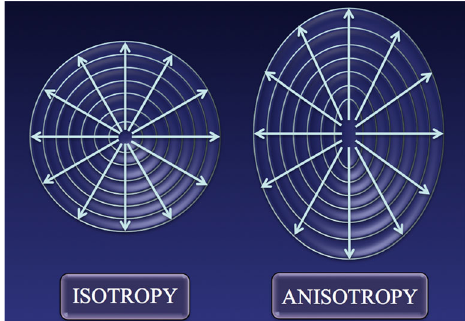
Fig.8 Schematic representationofanisotropicandananisotropicobject: in the latter, properties vary in the different planes. The term comes from ancient Greek words B ἄ νισ o ς ^ and B τρ o πή